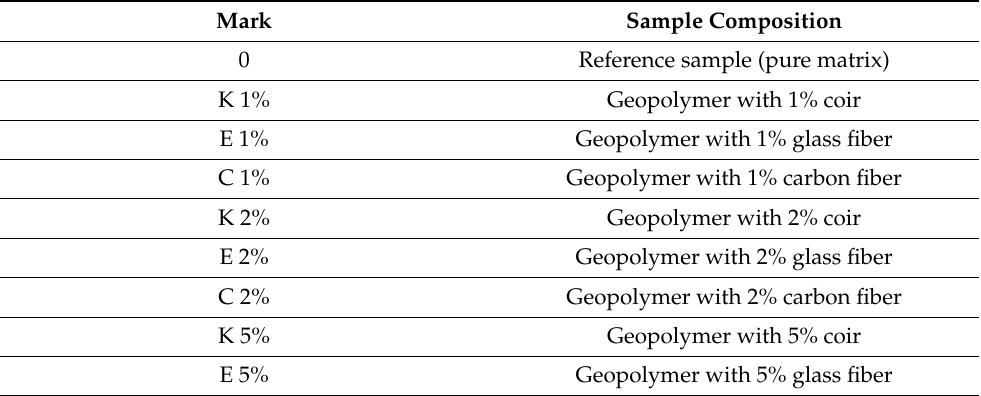
Table 5. Composition of the samples.